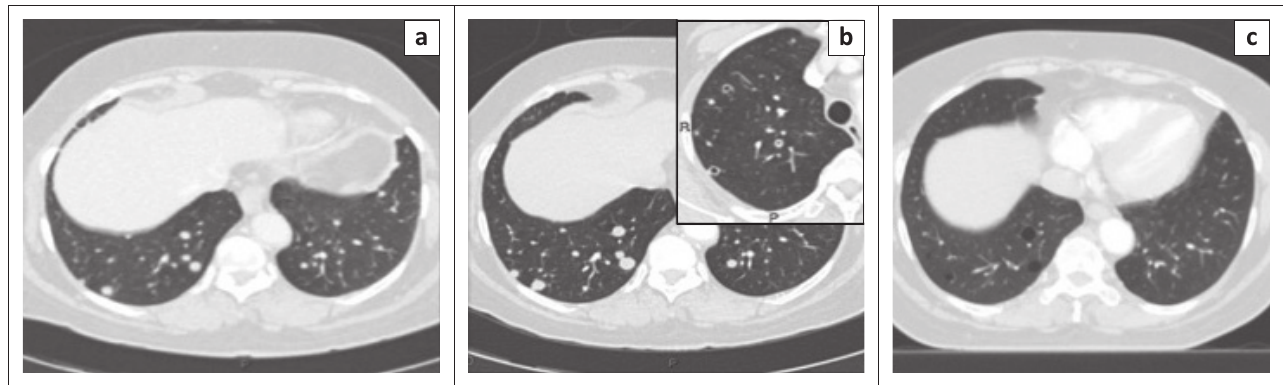
FIGURE 2: Consecutive computed tomography axial image series through the lung bases eloquently depicts the temporal evolution of: (a) solid pulmonary nodules to (c) thin-walled cysts. The magnified insert clearly demonstrates the central cavitation (b).